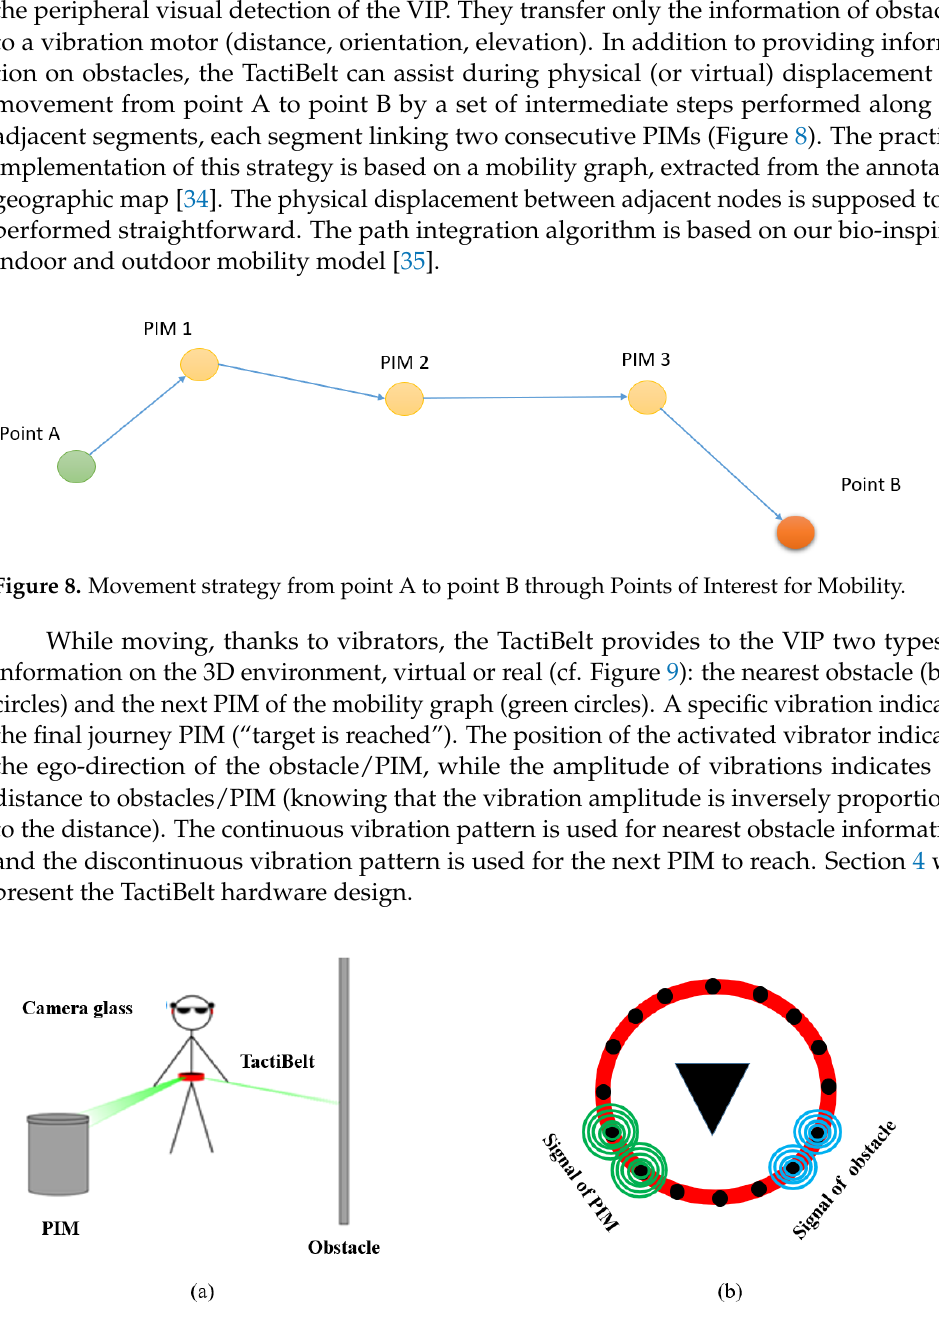
Figure 9. TactiBelt combined with glasses (stereo rig): ( a ) working principle; ( b ) generated stimu- lations. Green circles represent the next PIM to reach with a discontinuous vibration pattern. Blue circles represent the nearest obstacles with a continuous vibration